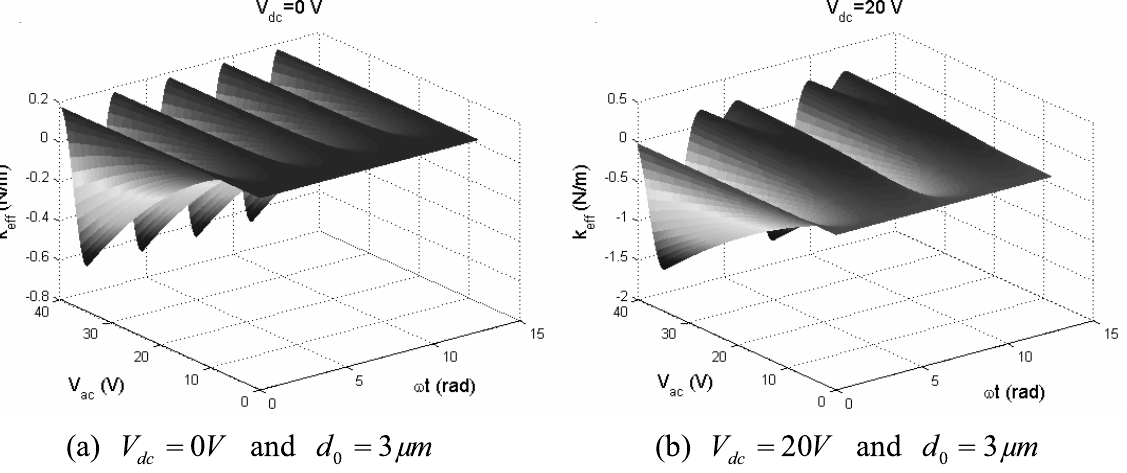
Fig. 2. Relationships between the effective stiffness and the dc bias voltage and the ac voltage: (a) V dc = 0 V and d 0 = 3 µm ; (b) V dc = 20 V and d 0 = 3 µm